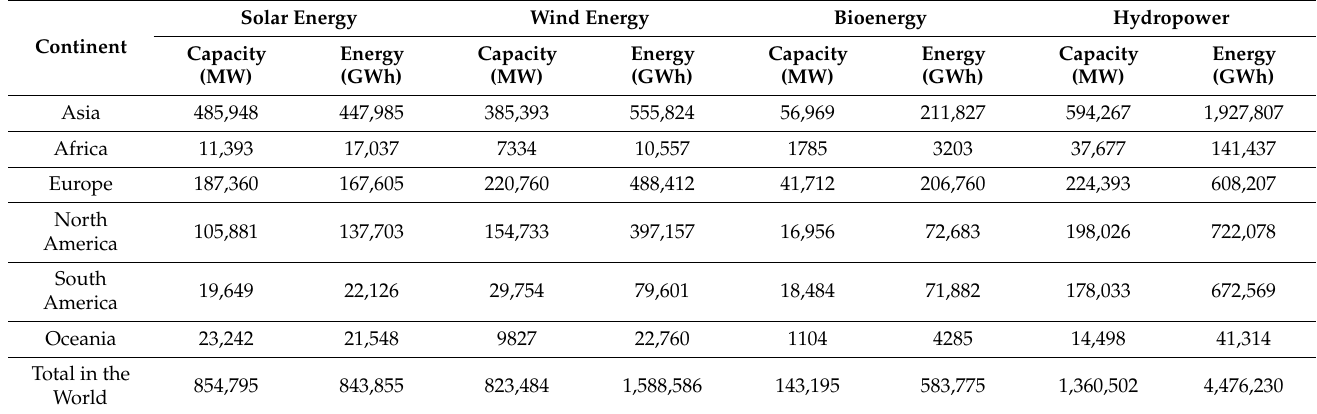
Table 4. Renewable energy installed capacities and electricity production in the world [108].